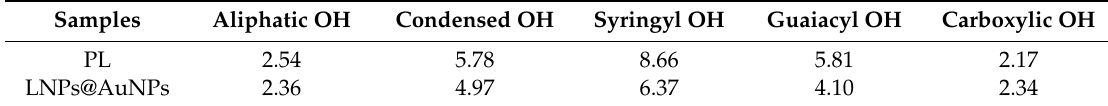
Table 1. Quantitative analysis of 31 P of PL.